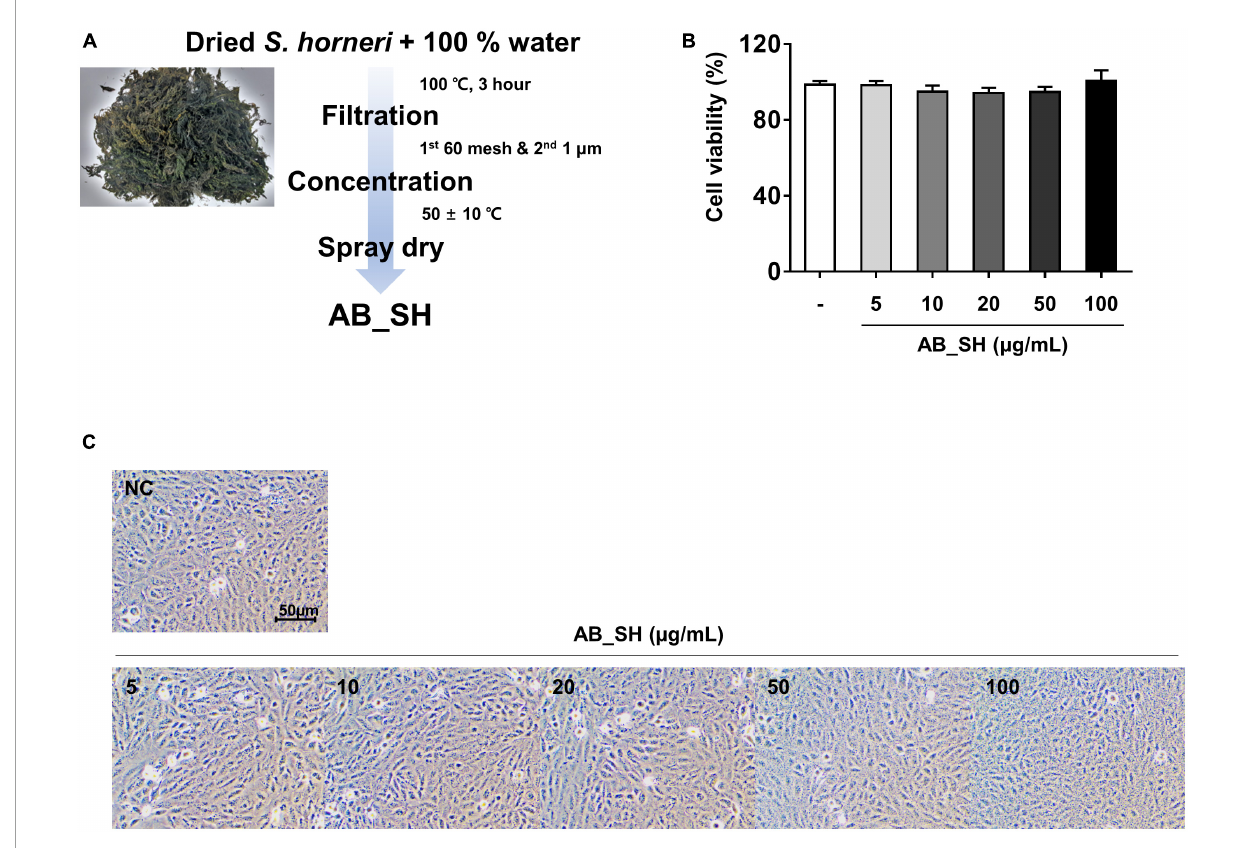
FIGURE1 Cell viability and cell morphology following AB_SH treatment of ARPE-19 cells. (A) Schematic diagram for the extraction process for AB_SH. ARPE-19 cells were treated with various concentrations of AB_SH. (B) cell viability and (C) cell morphology after treatment (5, 10, 20, 50, or 100 µ g/mL) for 24 h. The values represent the mean ± SD of three independent